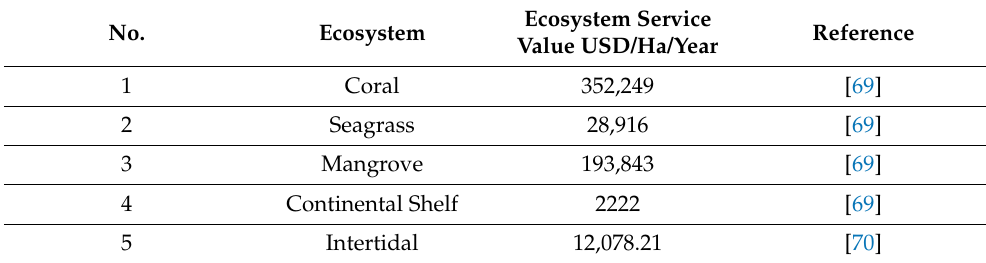
Table 1. Description of ecosystem service value for each ecosystem function and